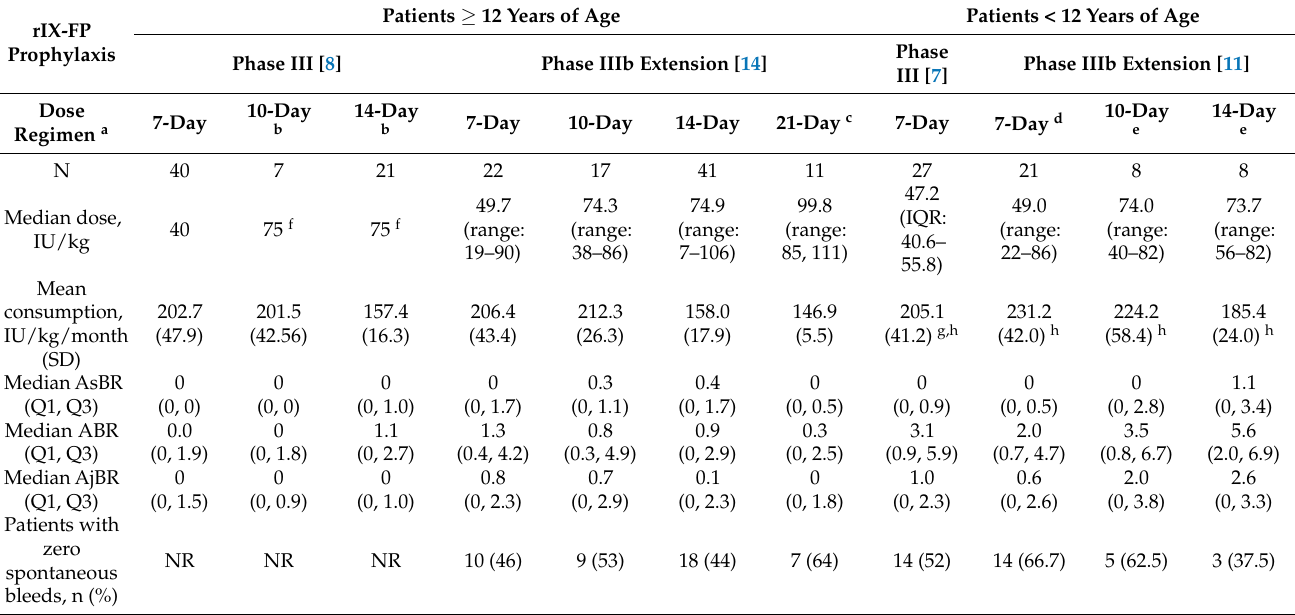
Table 2. Bleeding rates for patients treated with rIX-FP prophylaxis in phase III PROLONG-9FP